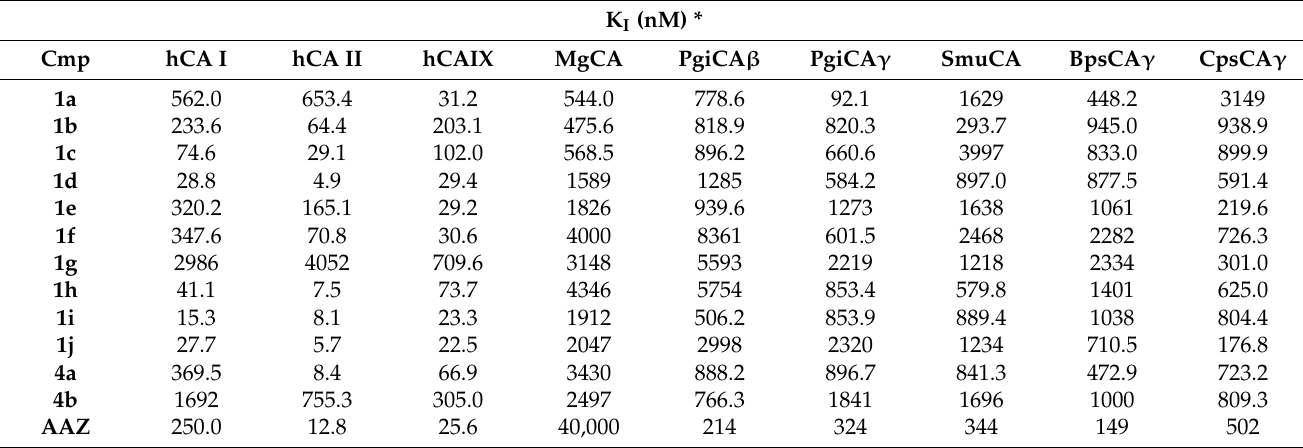
Table 2. Inhibition data of human CA isoforms I, II, IX, and β , γ from some bacterial and fungal strains with titled compounds and AAZ by a stopped-flow CO 2 hydrase